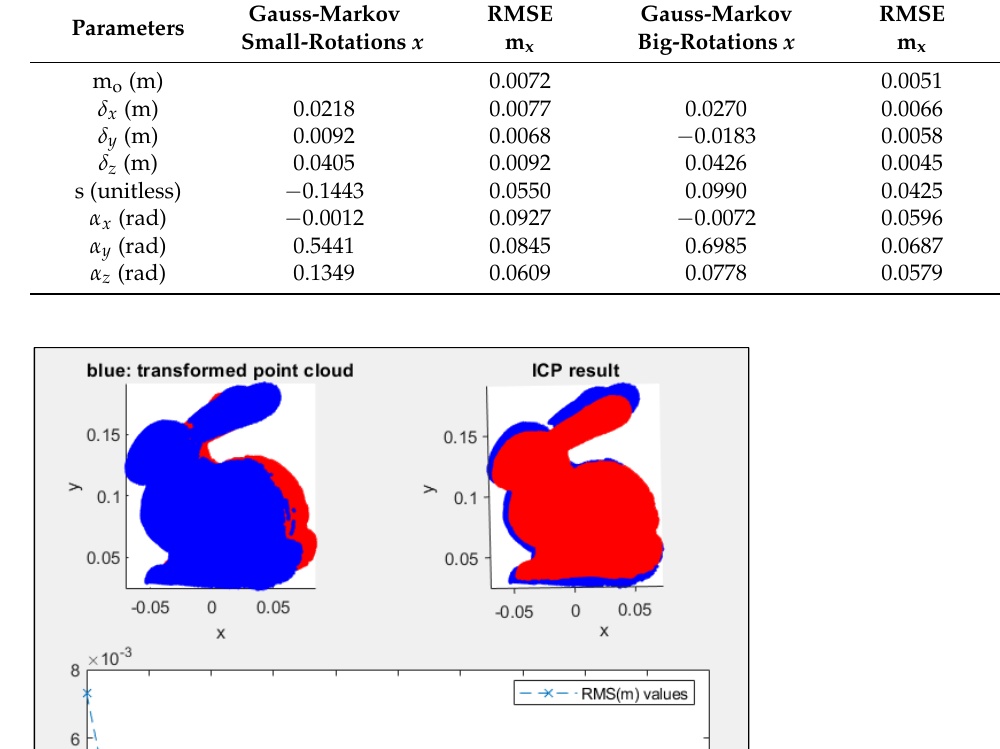
Table 5. Stanford bunny sculpture: transformation parameters ( x ) with their RMSE ( m x ) in coarse registration with the new algorithm.